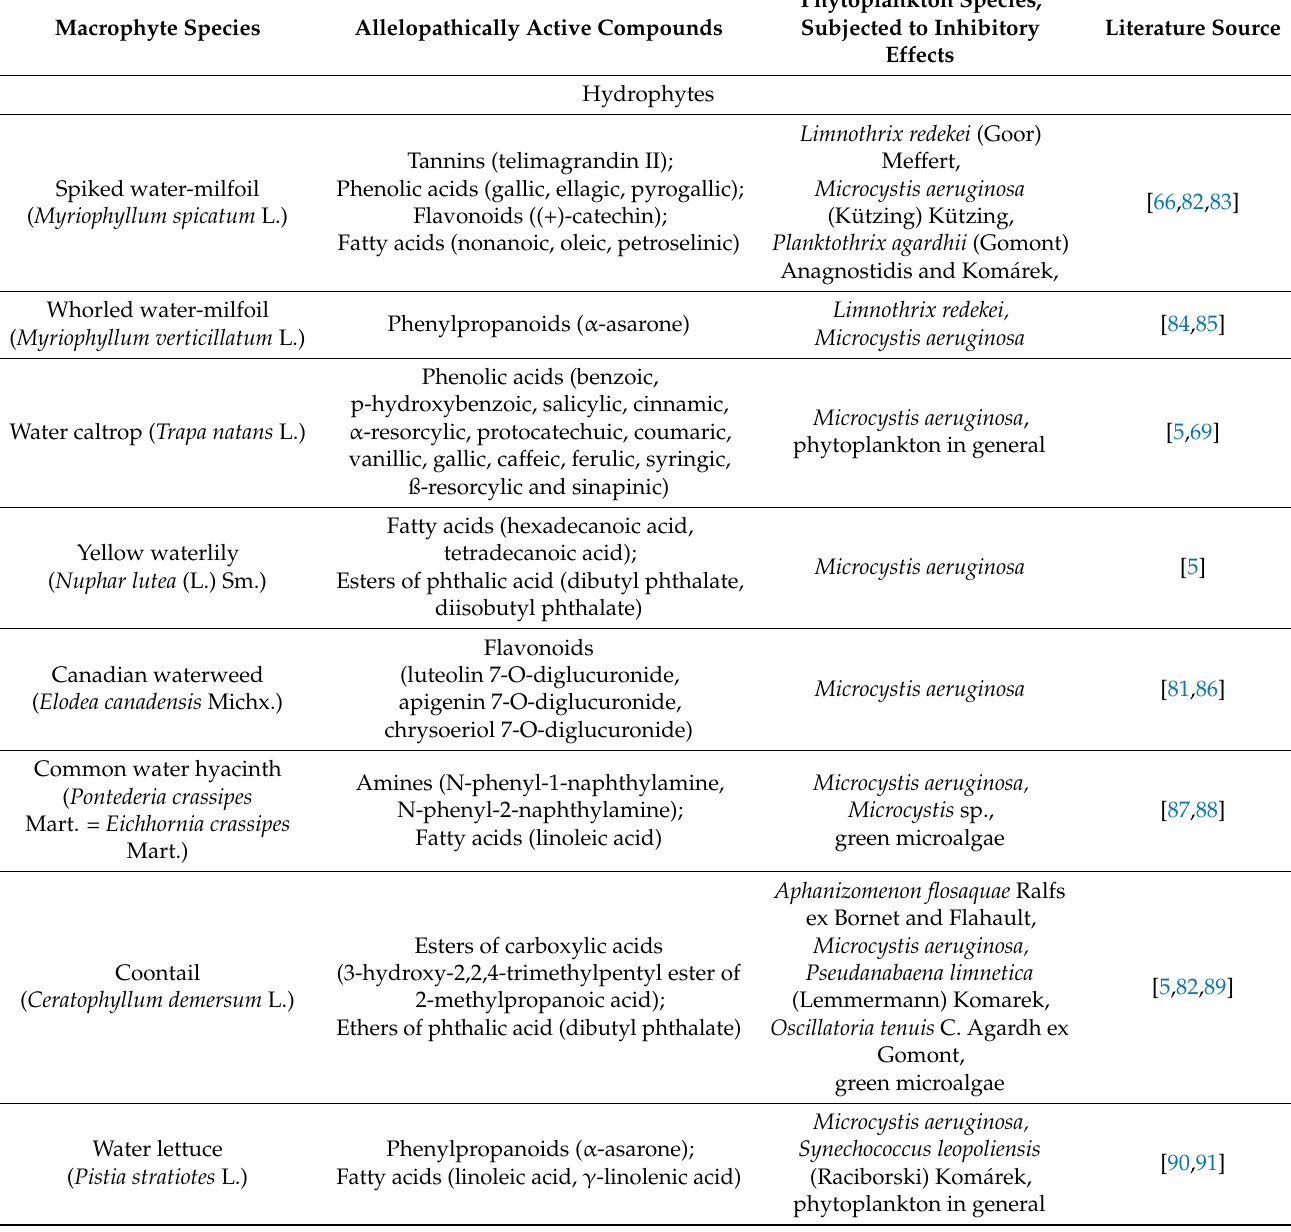
Table 1. The main allelopathically active compounds of some aquatic vascular plant species, which have inhibitory effects on